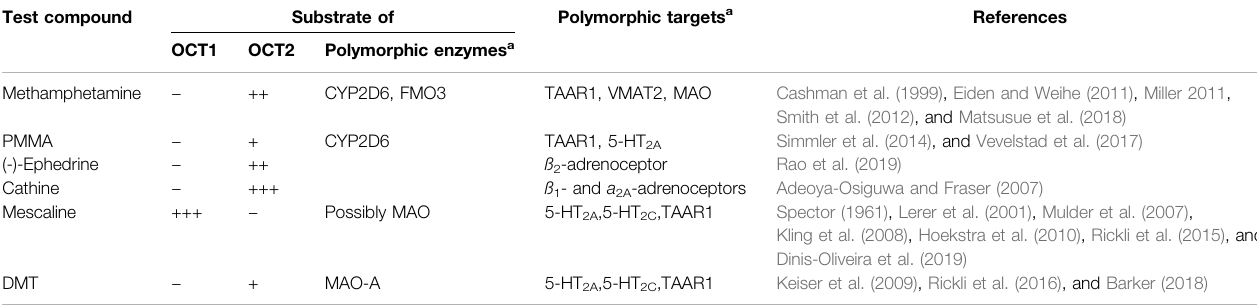
TABLE 3 | Pharmacogenetics of methamphetamine, PMMA, (-)-ephedrine, cathine, mescaline, and DMT (this list is not exhaustive). Test compound